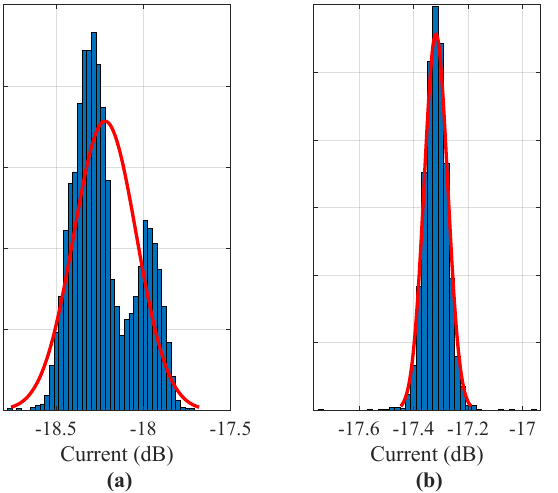
Figure 11. Even harmonics at high load sometimes cannot be lognormal modeled. An example of 900 mA load: ( a ) 100 Hz harmonic; ( b )150 Hz